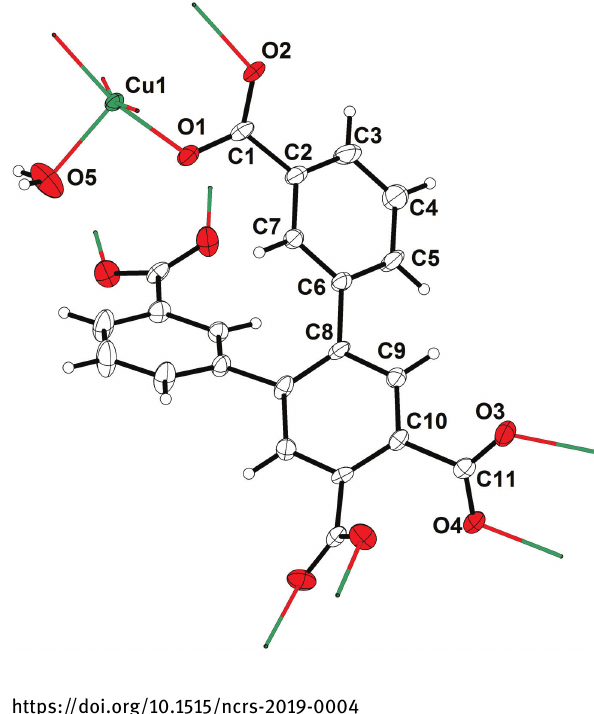
Table 1: Data collection and handling.